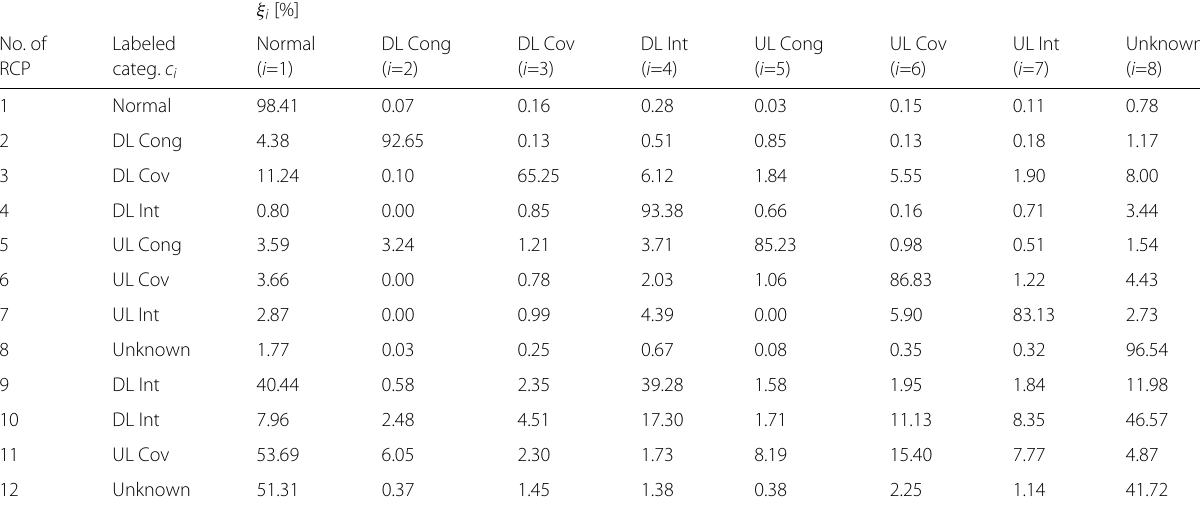
Table 5 Set of RCPs obtained by applying k -means with k